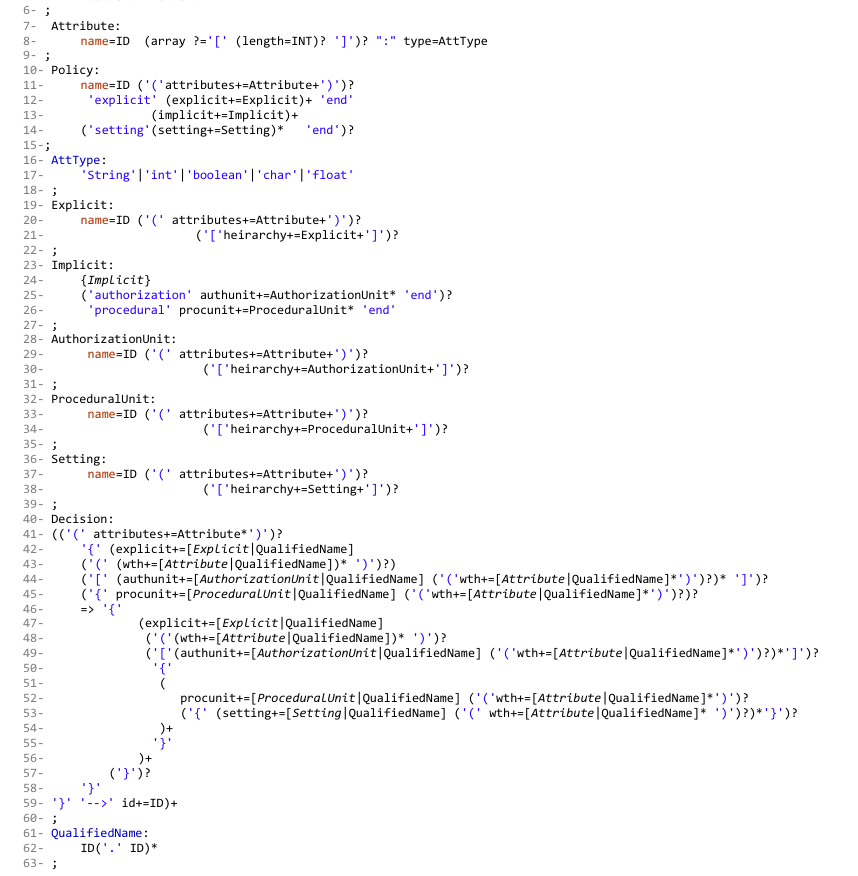
Figure 5. HEAD Metamodel: The